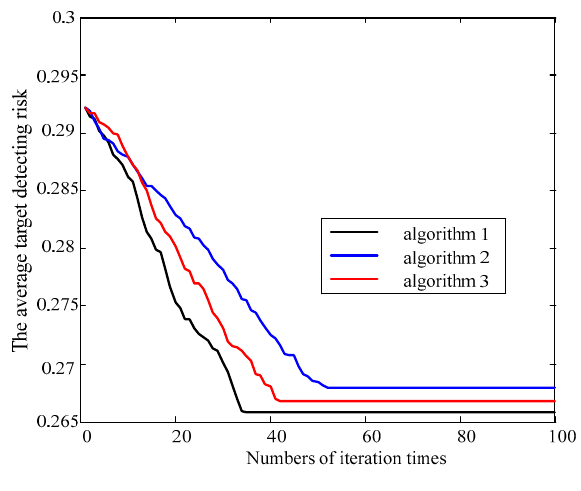
Figure 6. Algorithm iteration curves. Electronics 2019 , 8 , x FOR PEER REVIEW